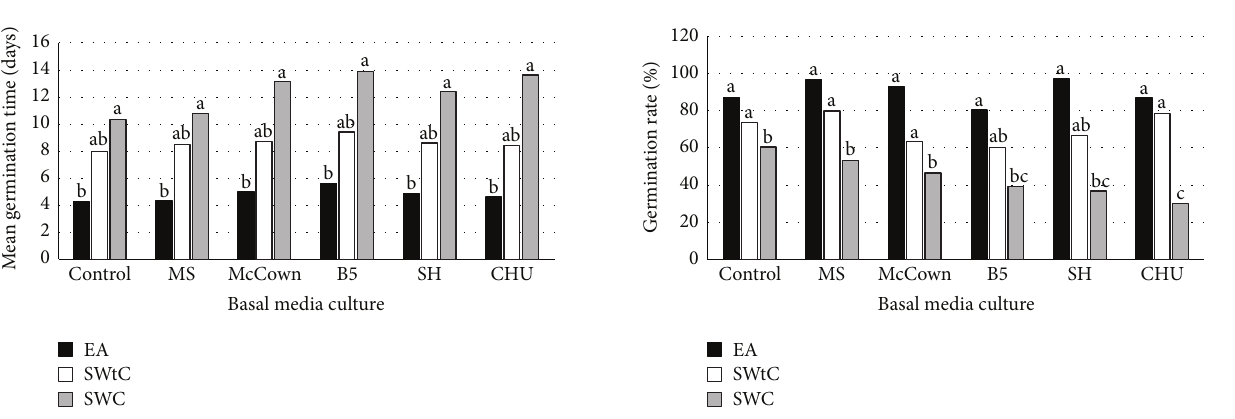
Figure2: MeangerminationtimeofdifferentseedstypeofBambara groundnut after three weeks of incubation on different basal media. EA: embryonic axis; SWtC: seed without seed coat; SWC: seed with seed coat.